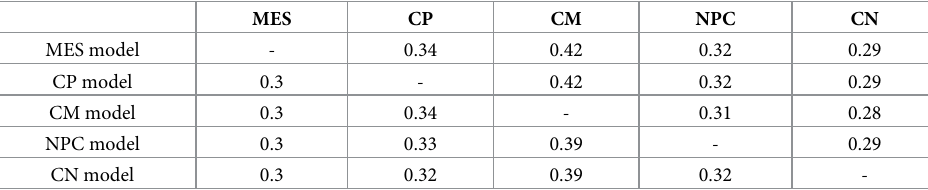
For each time point of cardiac (MES/CP/CM) and neural (NPC/CN) PE models (rows), the performance of the PE predictive models is shown for each cell type (columns). The performance values are represented as Pearson’s correlation ( r ) between the measured expression and the predicted one. CM, cardiomyocytes; CN, cortical neurons; CP, cardio precursors; MES, mesoderm; NPC, neural